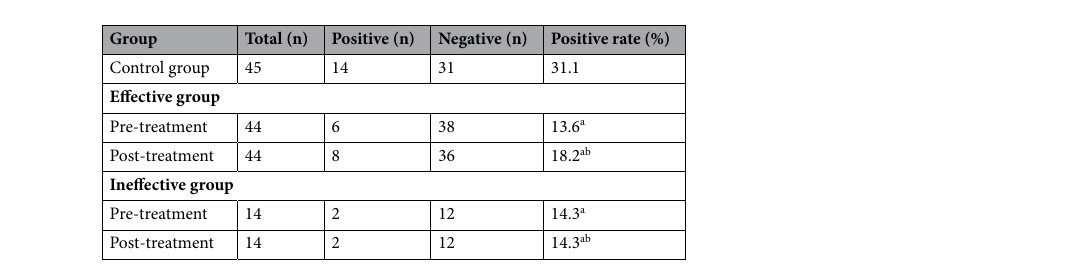
Figure 2. Detection results of P-gp immunohistochemical staining. ( A ) Results of P-gp staining in epithelial cells of healthy control colon tissues. ( B ) Results of P-gp staining in the lamina propria of healthy control colon tissue. ( C ) Results of P-gp staining in the epithelial cells of colon tissue of UC patients. ( D ) Results of P-gp staining in the lamina propria of colonic tissue from UC patients. Magnification is 400x.